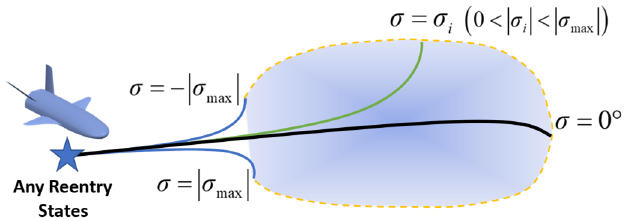
Figure 4. Reachable domain solved using constant bank angle method in the longitude–latitude profile. For any state x = [ V , h , γ , ψ , λ , φ , m ] , its corresponding domain boundary b = [ λ 1 , φ 1 , λ 2 , φ 2 , . . . , λ n , φ n ] can be obtained through the dynamic simulation